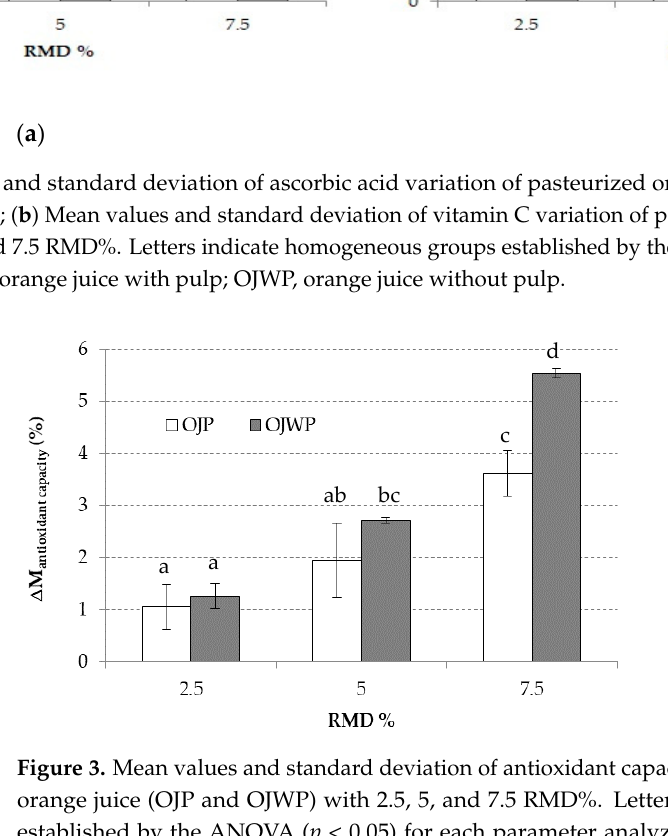
Figure 2. ( a ) Mean values and standard deviation of ascorbic acid variation of pasteurized orange juice (OJP and OJWP) with 2.5, 5, and 7.5 RMD%; ( b ) Mean values and standard deviation of vitamin C variation of pasteurized orange juice (OJP and OJWP) with 2.5, 5, and 7.5 RMD%. Letters indicate homogeneous groups established by the ANOVA ( p < 0.05) for each parameter analyzed. OJP, orange juice with pulp; OJWP, orange juice without pulp.